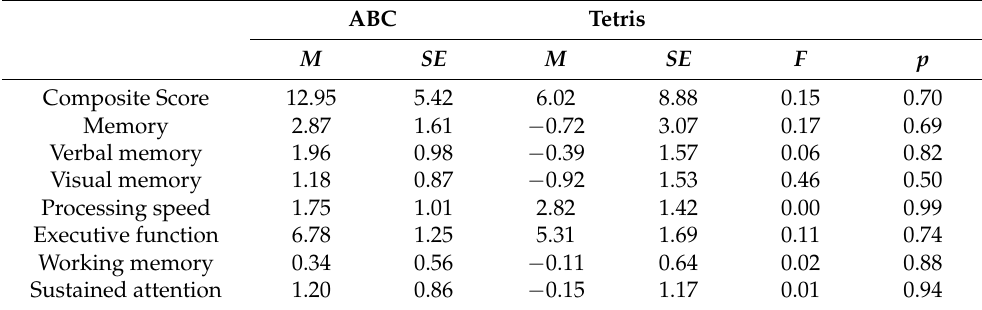
Table 4. Change scores and results from ANCOVAs examining between group differences in cognitive function change